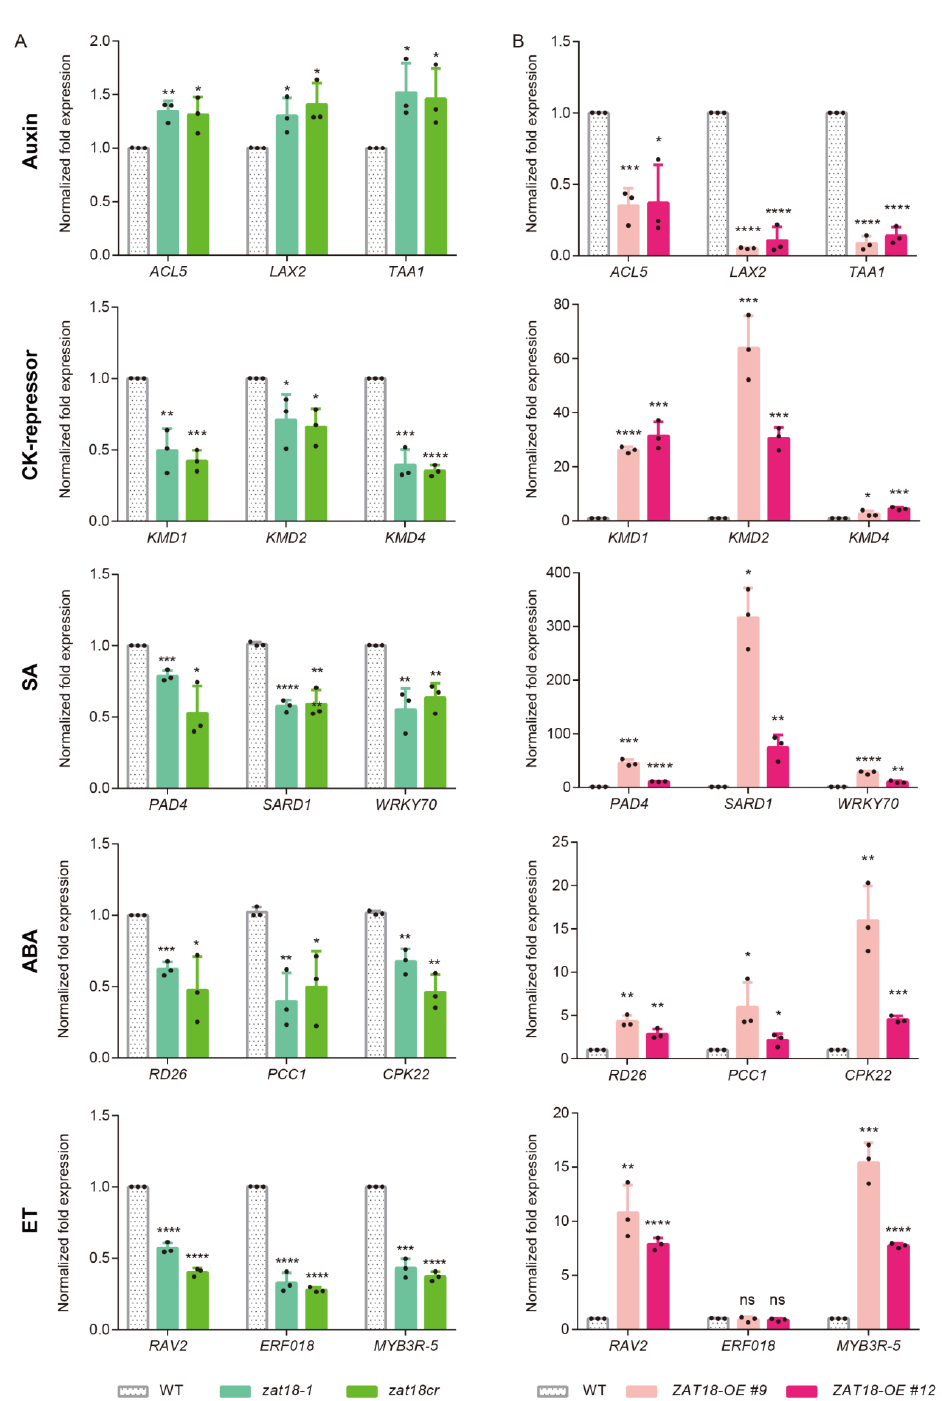
Figure 7. Validation of the expression levels of hormone-related DEGs in the zat18 mutant and ZAT18-OE lines using qRT-PCR. ( A ) The expression levels of representative hormone-related genes identified using RNA sequencing of the zat18 mutants. ( B ) The expression levels of representative hormone-related genes identified using RNA sequencing of the ZAT18-OE lines. n = 3, n indicates the number of biological replicates. * p < 0.05; ** p < 0.01; *** p < 0.001; **** p < 0.0001; ns, no significant difference.